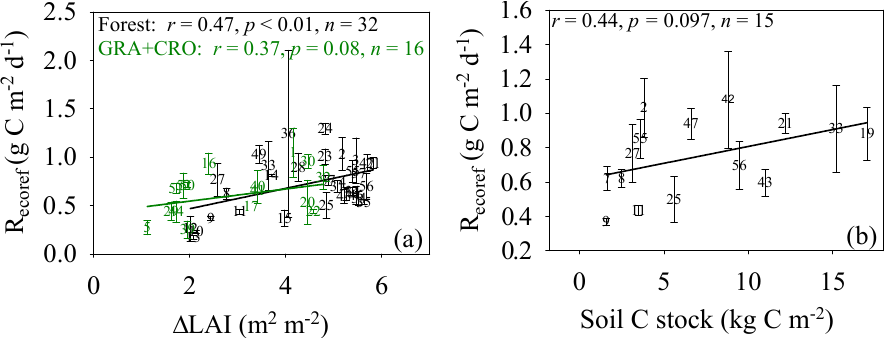
Fig. 2. The relationship between reference winter respiration ( R ecoref ) calculated from the Arrhenius function and 1 LAI (m 2 m − 2 ) (a) and total soil carbon stock (kgCm − 2 ) (b) across sites. The site-specific R ecoref is averaged from its site years, and its error bar is the standard deviation of R ecoref over the site-years. All values are calculated according to winter definition D